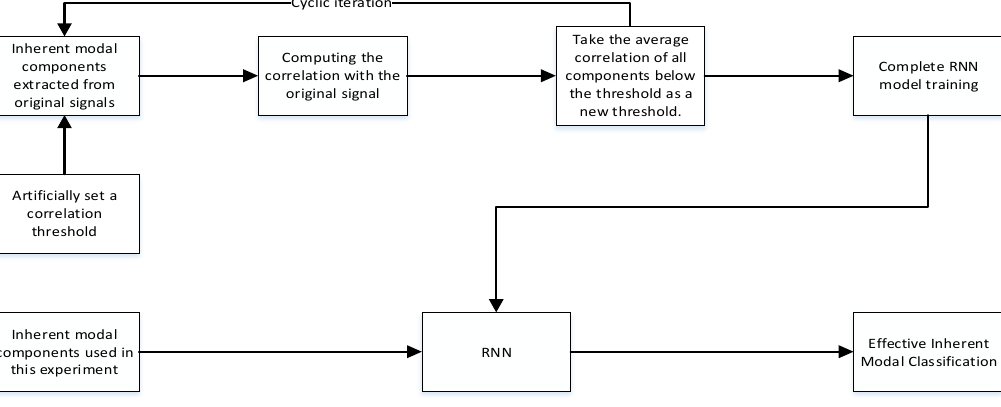
Figure 4. The flow chart of LSTM training.